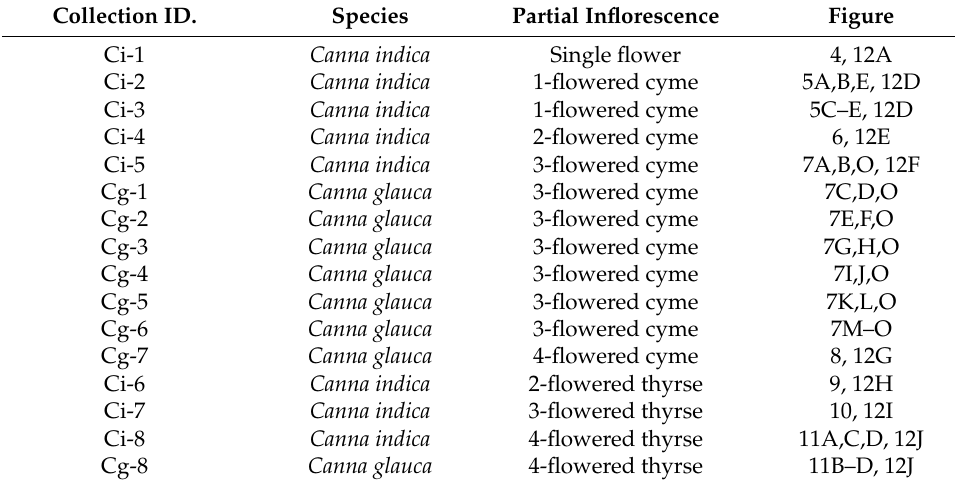
Table 1. List of aberrant flower collections